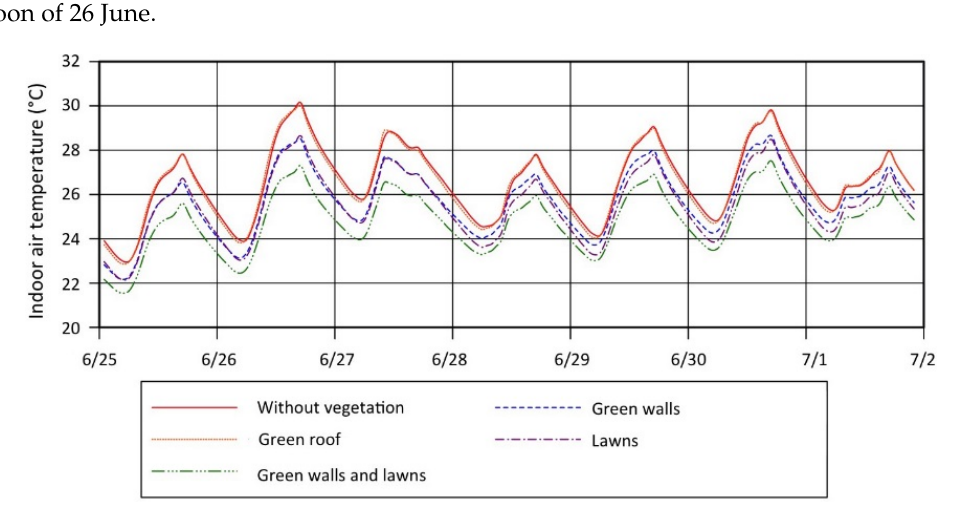
Figure 14. Indoor temperatures on the third floor for various greening configurations.